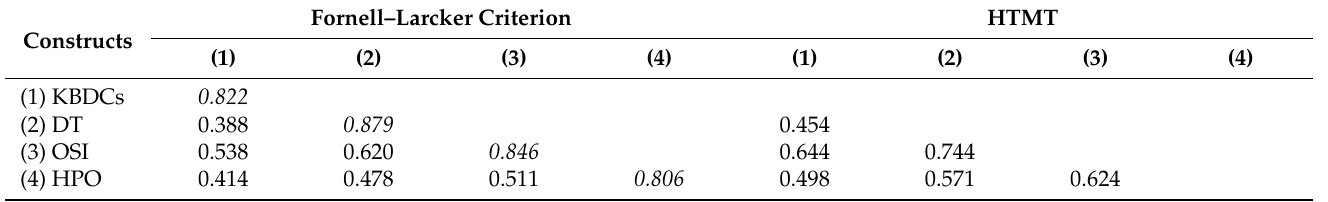
Table 4. Discriminant